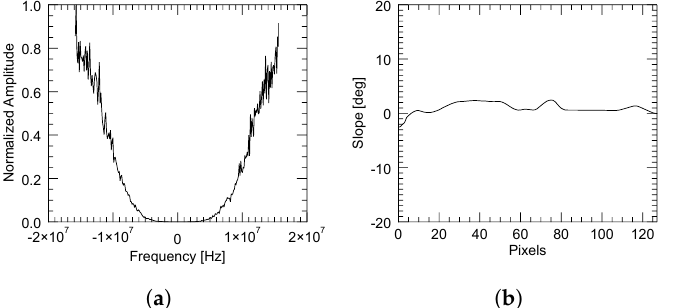
Figure 14. Computed normalized power spectrum ( a ) with the adaptive method in a region with an almost constant slope ( b ) but with strong decorrelation. A low SNR does not allow a clear identification of the peak.